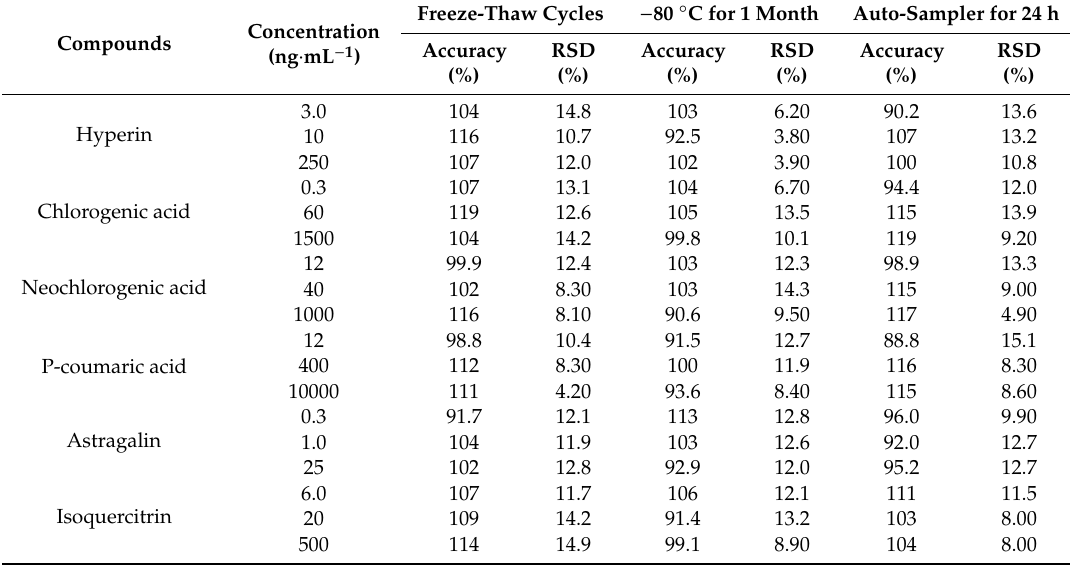
Table 4. Stability of six compounds ( n =